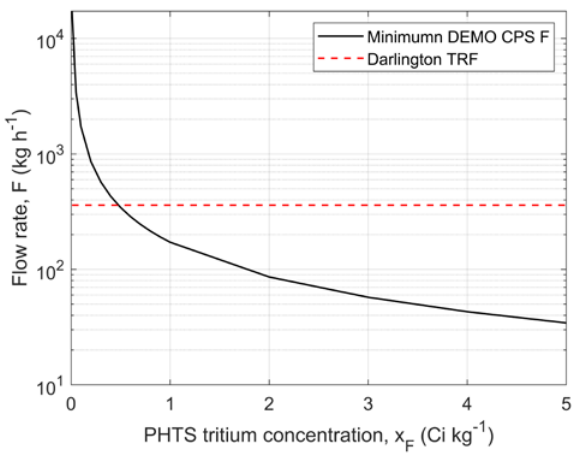
Figure 3. CPS feeding flow rate as a function of the PHTS maximum tritium concentration target for a source term of 0.43 g d −1 and a CPS efficiency of 100%. a source term of 0.43 g d − 1 and a CPS efficiency of